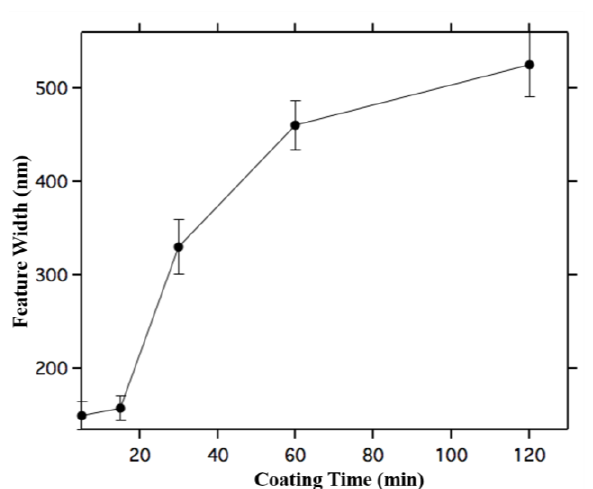
Figure 2. Average width of assembled nanoparticle features as a function of coating time. Error bars are 1 σ standard deviation taken by averaging many linescans obtained from the SEM image shown in Figure 1. Note that the width increases slowly at first, accelerates, and then slows down again.